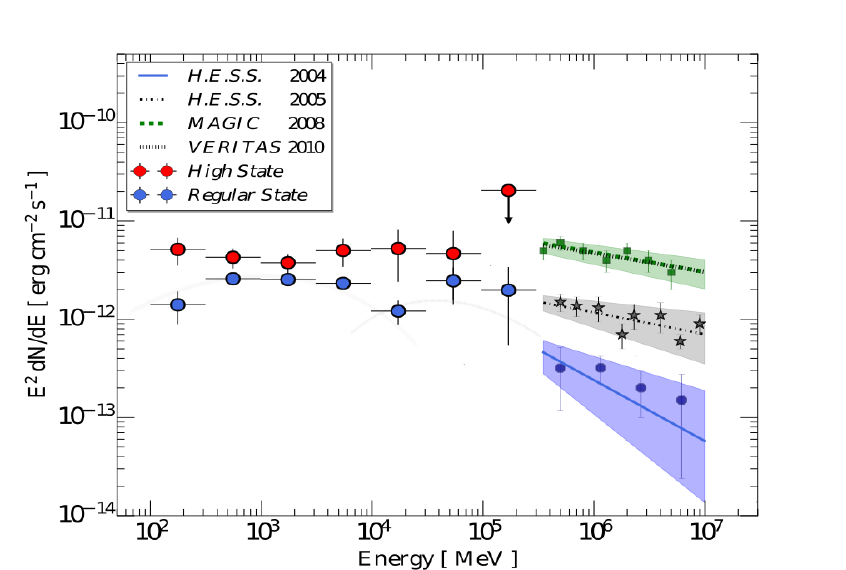
Figure 5. Gamma-ray SED for M87 based on ∼ 8 year of Fermi-LAT data including the different observed VHE states. The average ("regular") spectrum shows a break in the SED around ∼ 10 GeV, suggestive of an additional HE component. The break appears masked in the "high state" by flaring above ∼ 10 GeV. The current situation now in principle allows for a smooth connection of HE and VHE states. This suggests that the nature of this additional component is constrained by the observed VHE variability. The light grey curves for the two components are intended to guide the eyes only. Following Ref.